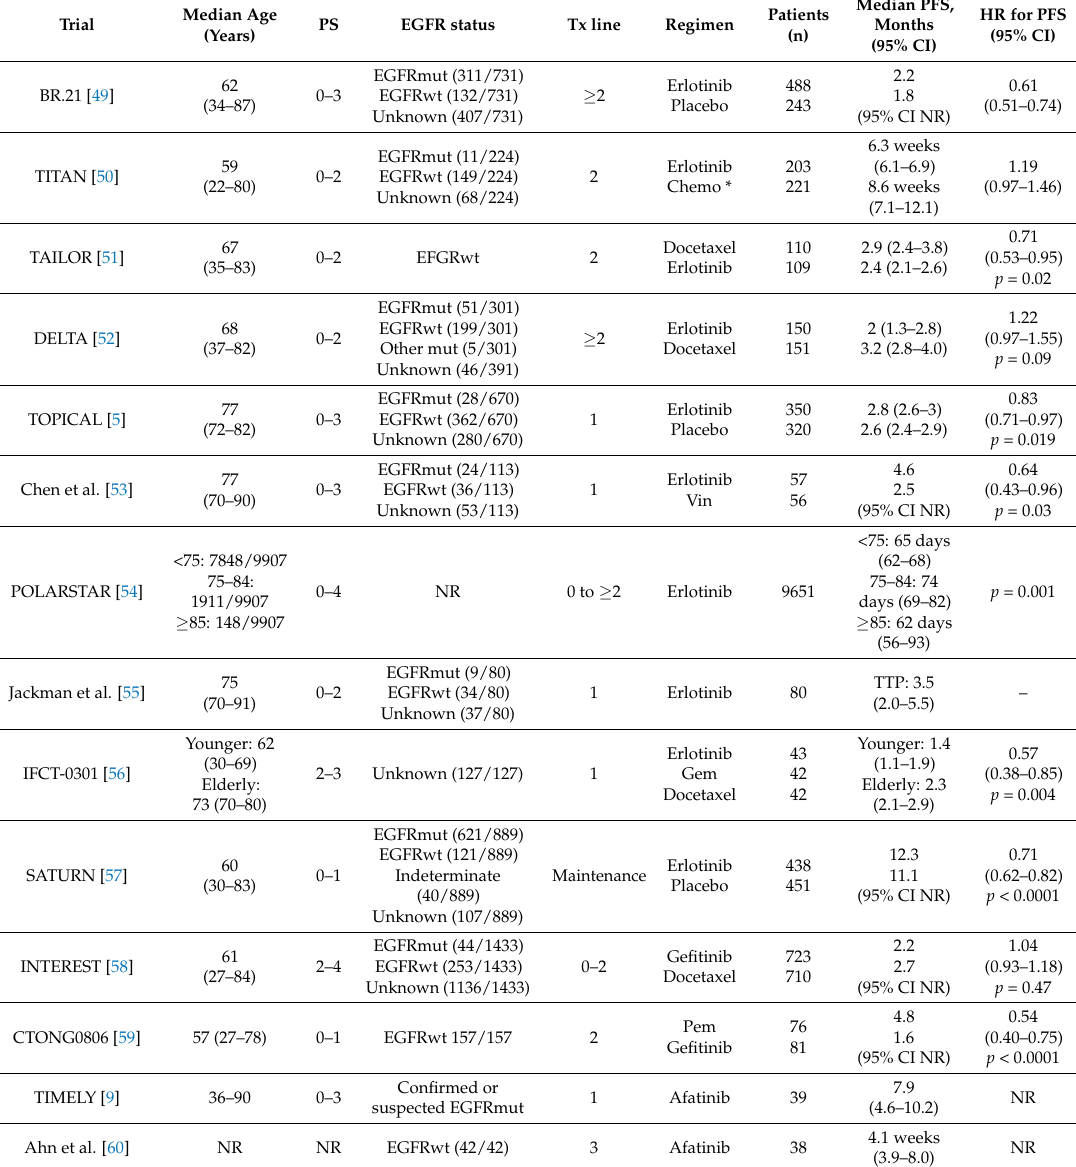
Table 3. Trials of EGFR TKI’s in patients with advanced wild type